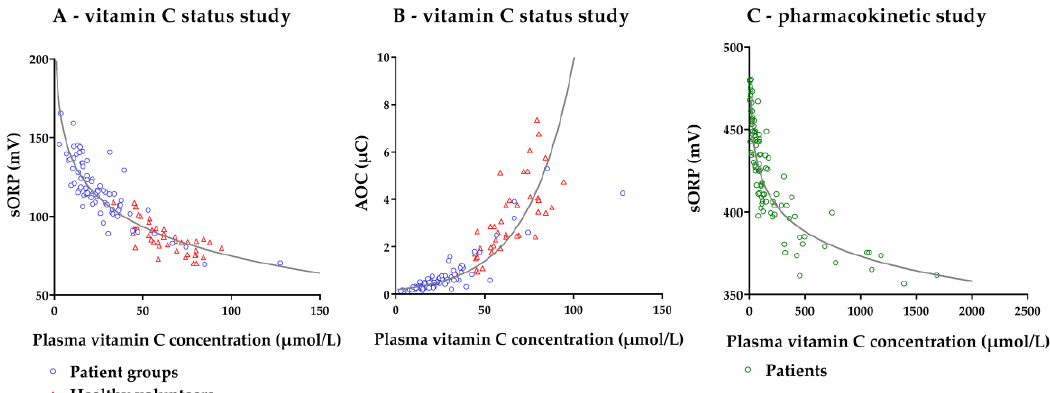
Figure 5. Scatter plot of the association between plasma vitamin C concentration and concomitant static oxidation reduction potential (sORP) and antioxidant capacity (AOC) in the vitamin C status study ( A + B ) and pharmacokinetic study ( C ). A : sORP = − 26.89 ln(plasma vitamin C concentration) + 198.69; B : AOC = 0.199 × e 0.039(plasma vitamin C concentration) ; C : sORP = − 21.74 ln(plasma vitamin C concentration) + 523.46.